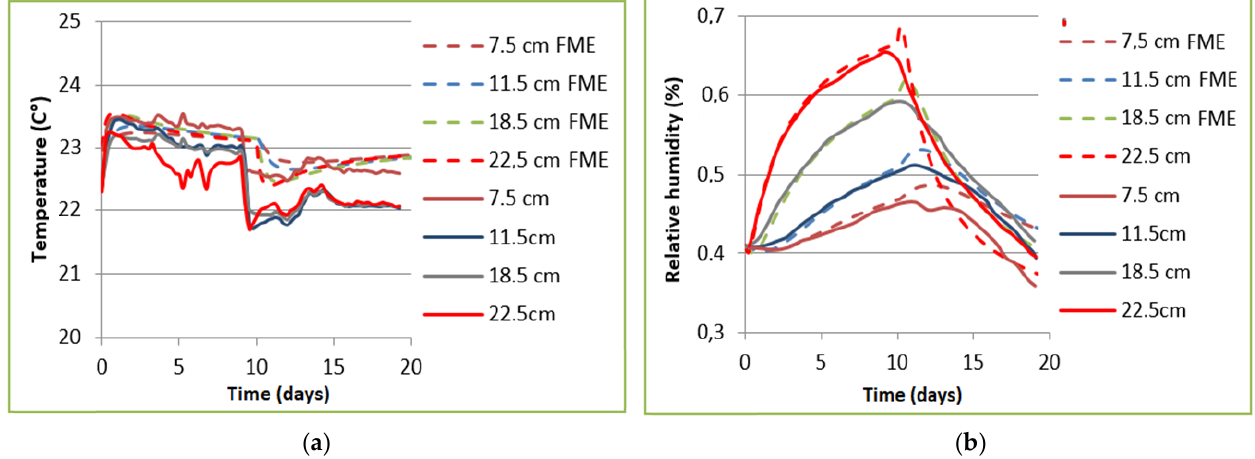
Figure 7. Comparison of temperature (T) ( a ) and relative humidity (RH) ( b ) of the numerical results obtained by the heat, air and moisture (HAM) model presented above and the experimental results [24].